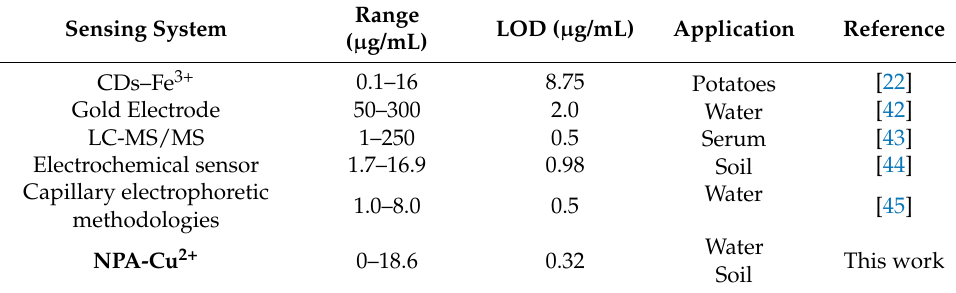
Table 2. Comparison of different strategies to detect